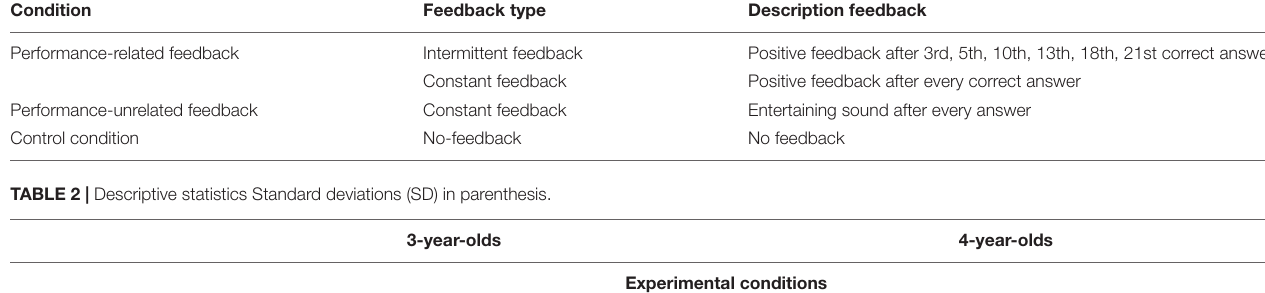
TABLE 1 | Overview Experimental Conditions.